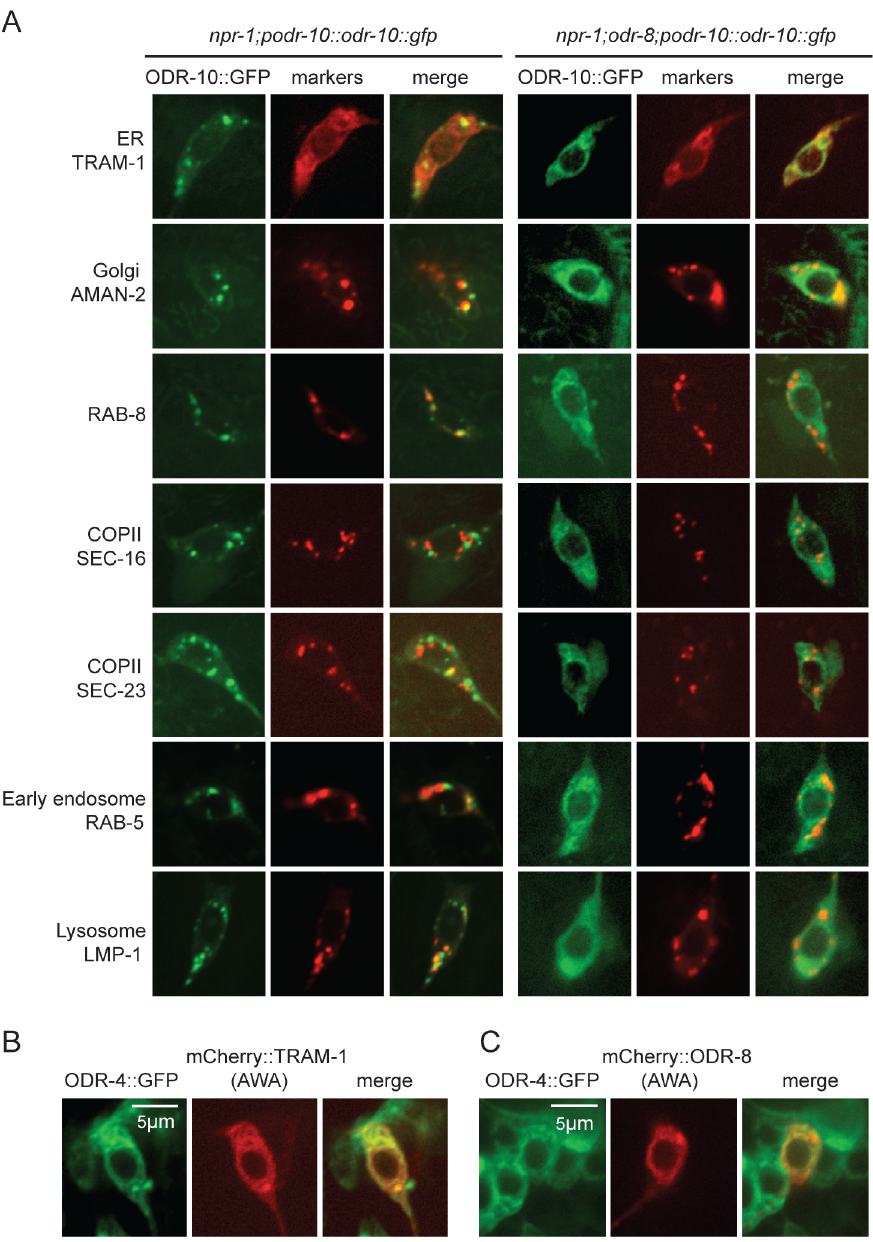
Figure 4. ODR-10-GFP is retained in the ER in odr-8 mutants. (A) ODR-10-GFP co-localizes predominantly with RAB-8 and LMP-1 markers in wild type animals, but with ER markers in odr-8(ky31) mutants. (B–C) ODR-4 co-localizes with the ER marker TRAM-1 (B), and ODR-4 and ODR-8 partially co-localize with each other (C).